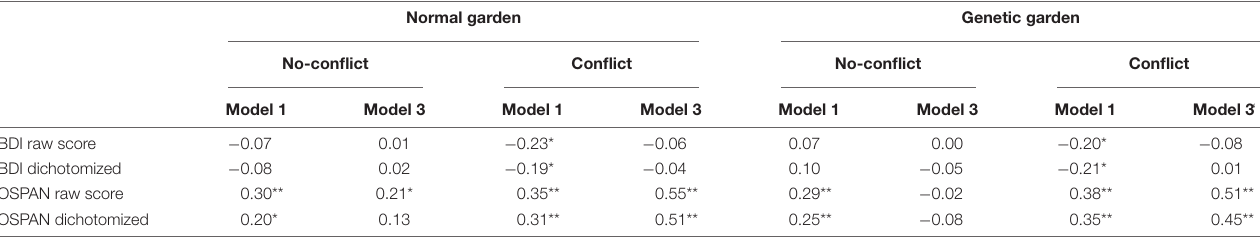
TABLE 2 | Correlations between depression measure BDI (raw score and dichotomized), operation span of working memory OSPAN (raw score and dichotomized), and accuracy of syllogistic reasoning for different kinds of syllogisms. Normal